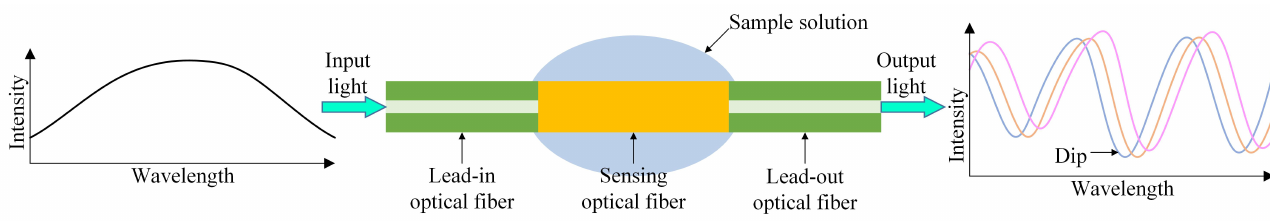
Figure 6. The schematic diagram of salinity measurement based on wavelength